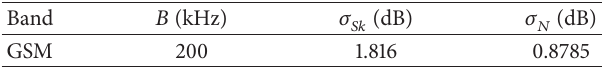
Figure 6: Measured and forecasted time series for GSM channels with the wavelet neural model.